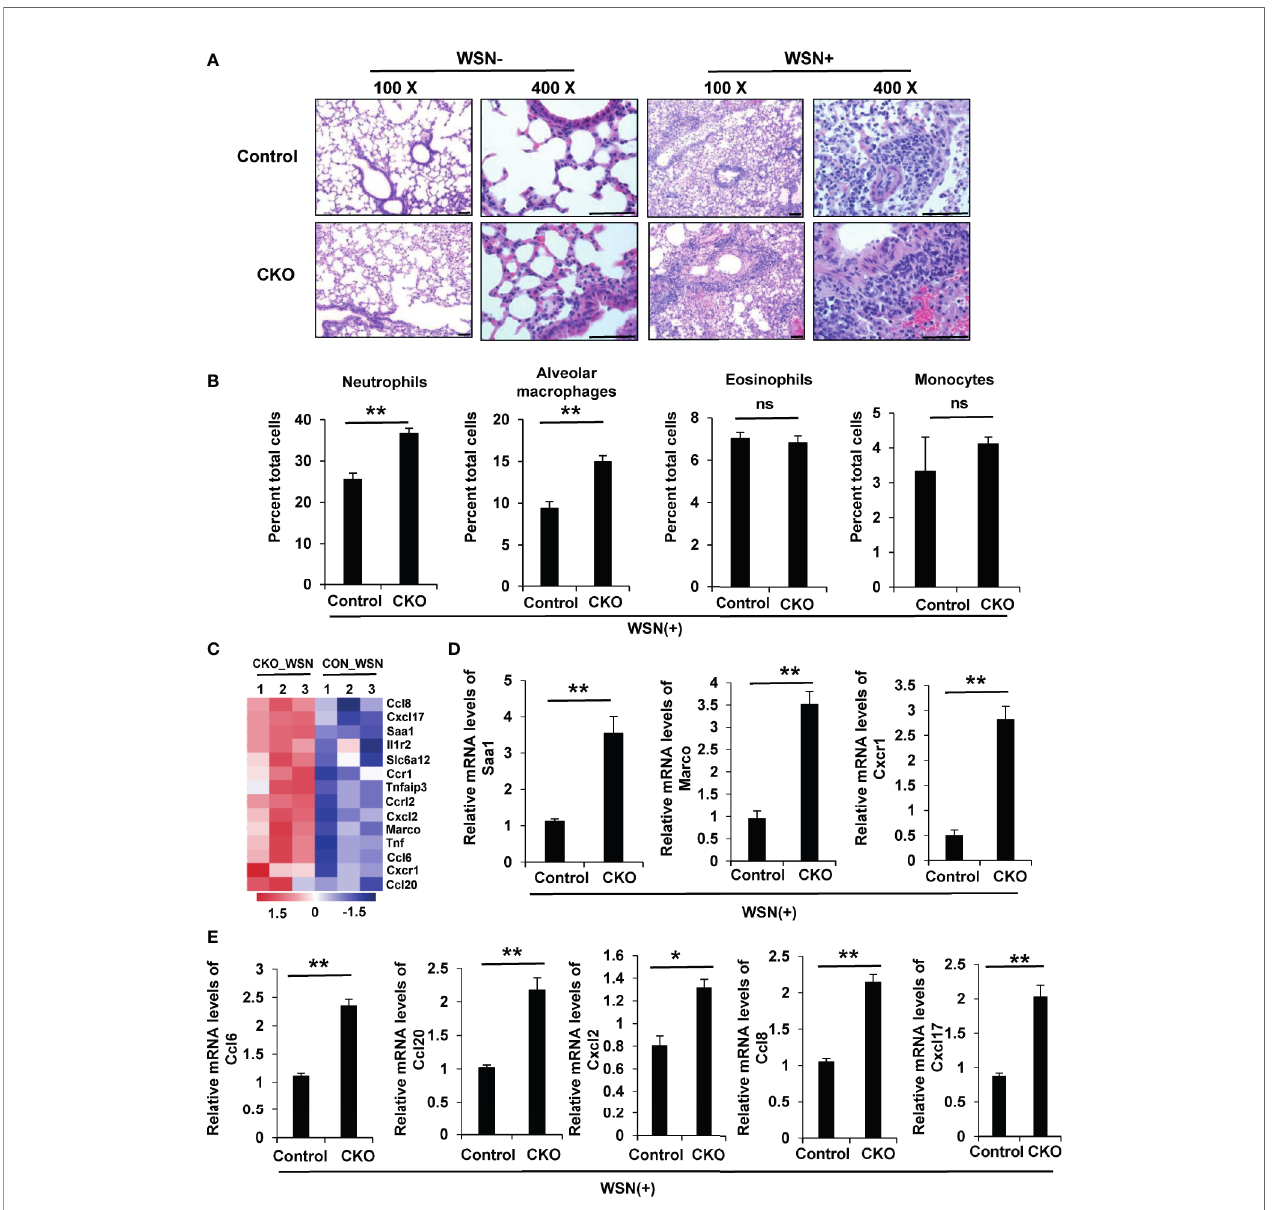
FIGURE 5 | Knockout of eIF4B enhances pulmonary in fl ammation induced by virus infection. (A) Representative HE-staining images of lung tissue sections from eIF4B CKO and control mice with or without viral infection. Scale bars, 100 µm. (B) Flow cytometry of single-cell suspensions of the lungs from eIF4B CKO and control mice infected with WSN. (C) Shown are the differentially expressed in fl ammation-associated factors in WSN-infected lungs of eIF4B CKO mice compared to those in control mice. (D, E) Levels of several important in fl ammation-associated factors (D) or chemokines (E) were examined by qRT-PCR. Data are represented as mean ± SD. ns, not signi fi cant; **p ≤ 0.01 and *p ≤